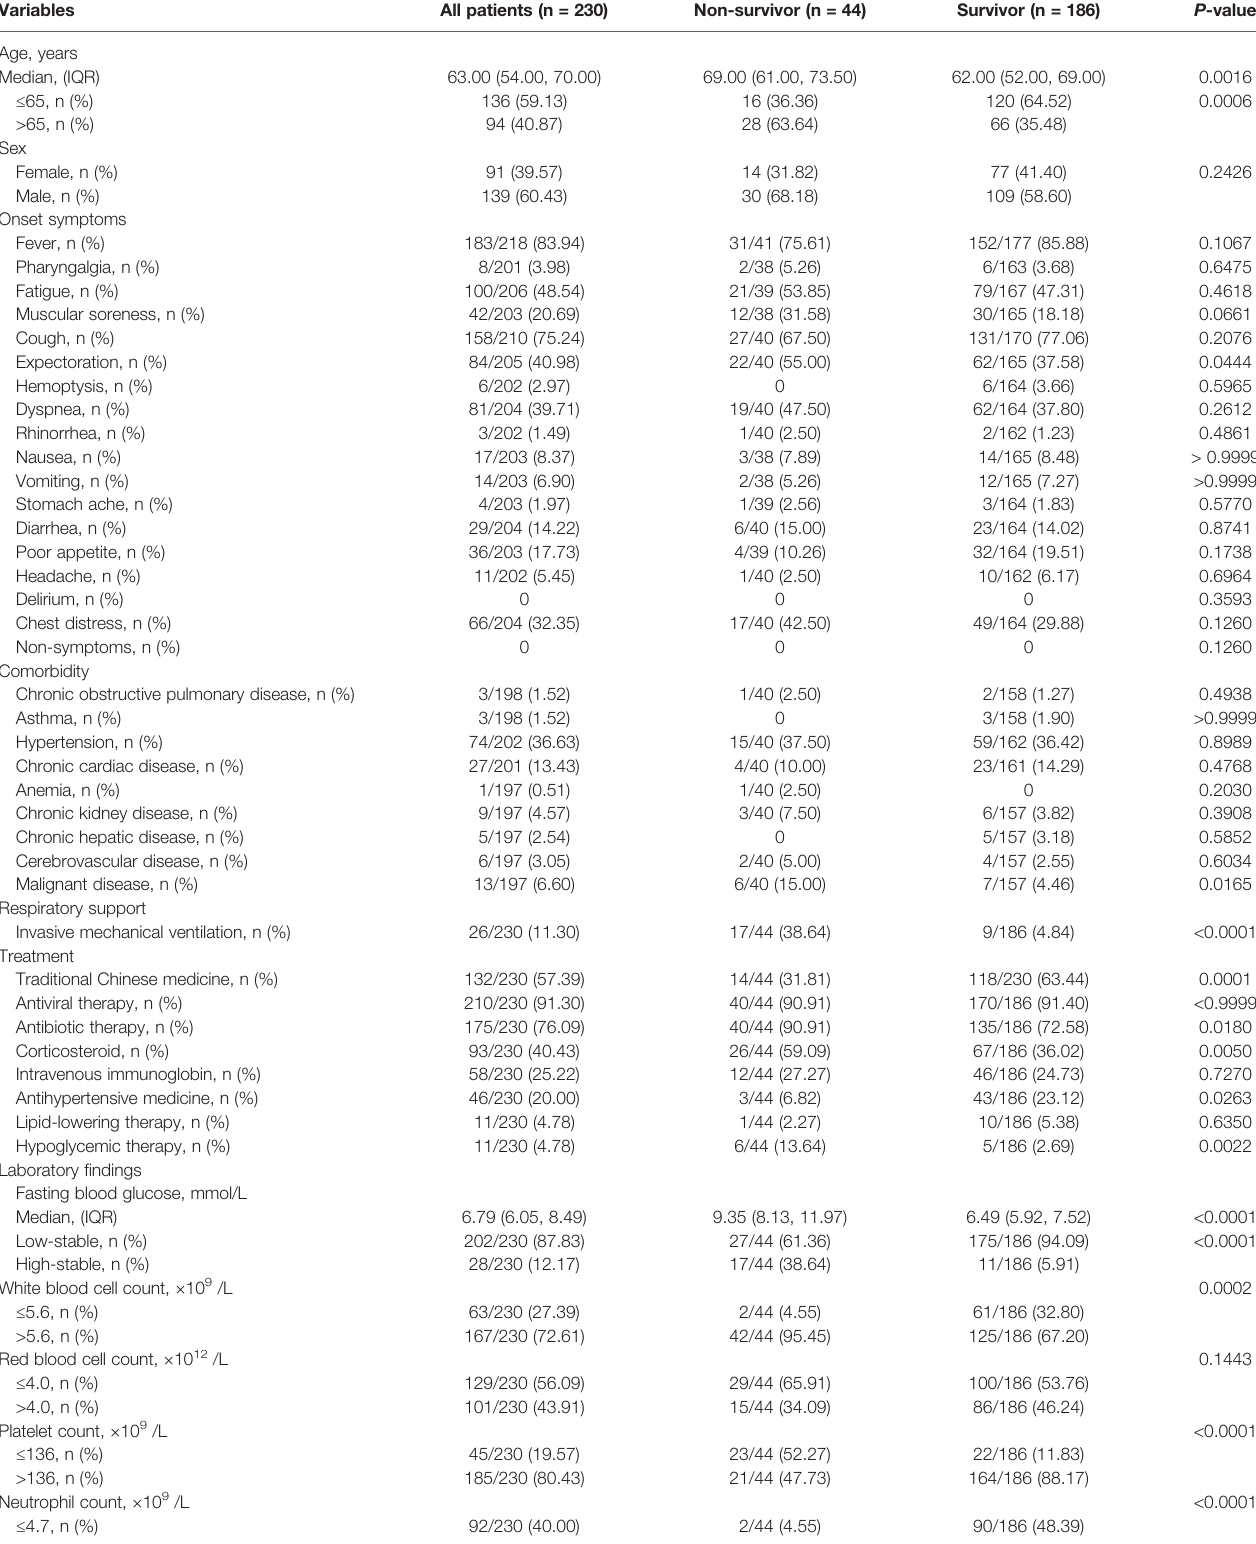
TABLE 1 | Baseline clinical characteristics and laboratory fi ndings concerning patients with COVID-19 and hyperglycemia without previous diagnosis of diabetes.